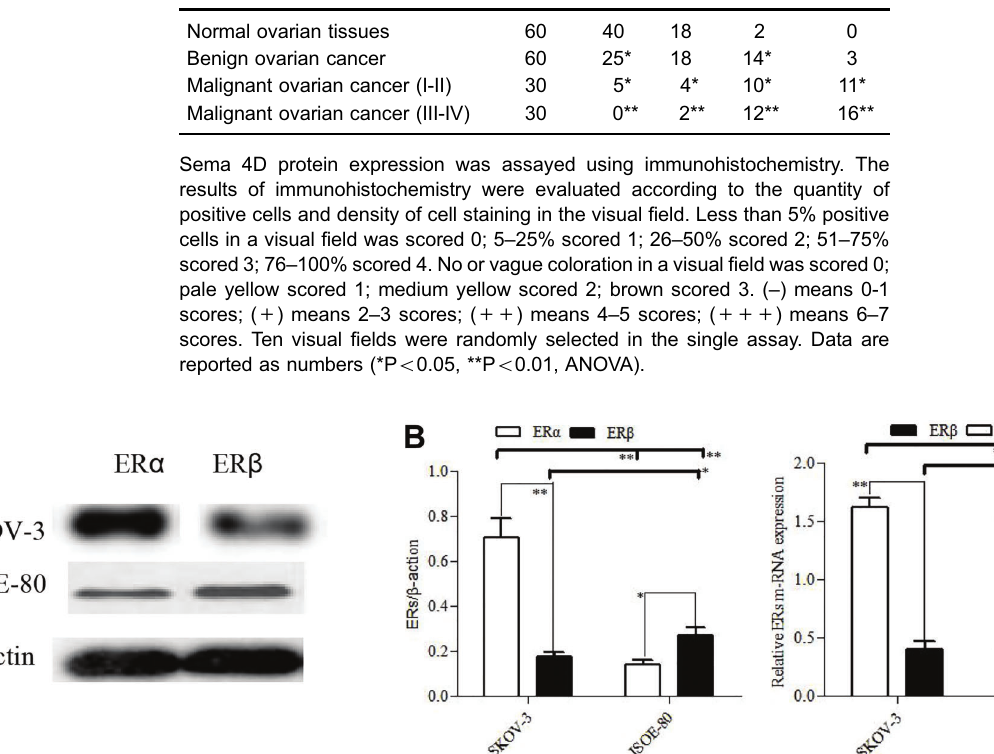
Table 1. Semaphorin (sema) 4D protein expression levels in different ovarian tissues. Groups